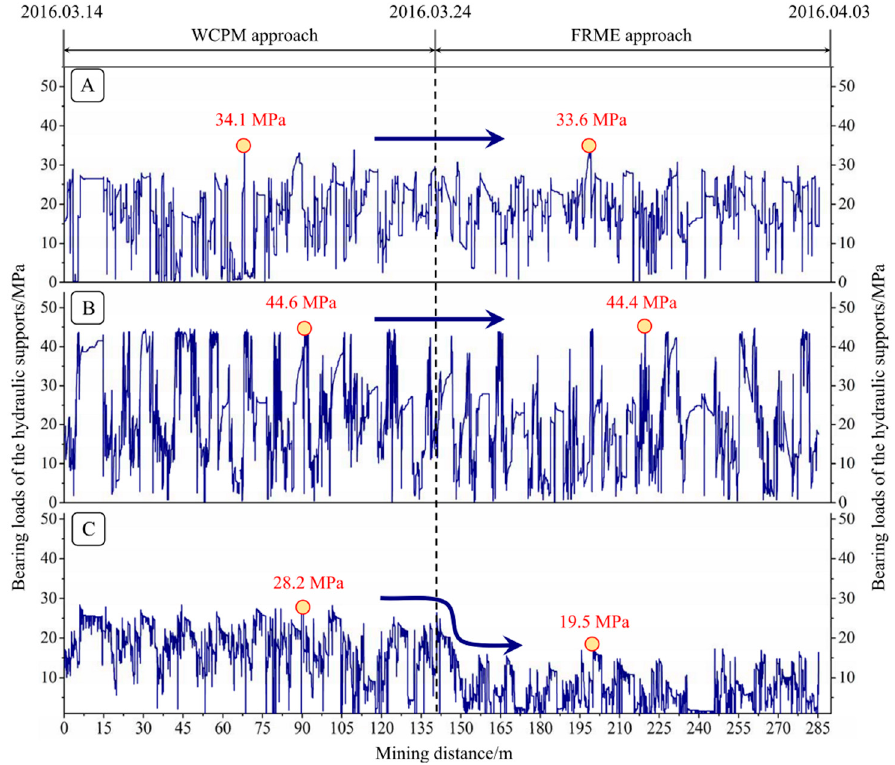
Figure 19. Monitoring results of the roof pressures in the S1201 working panel.